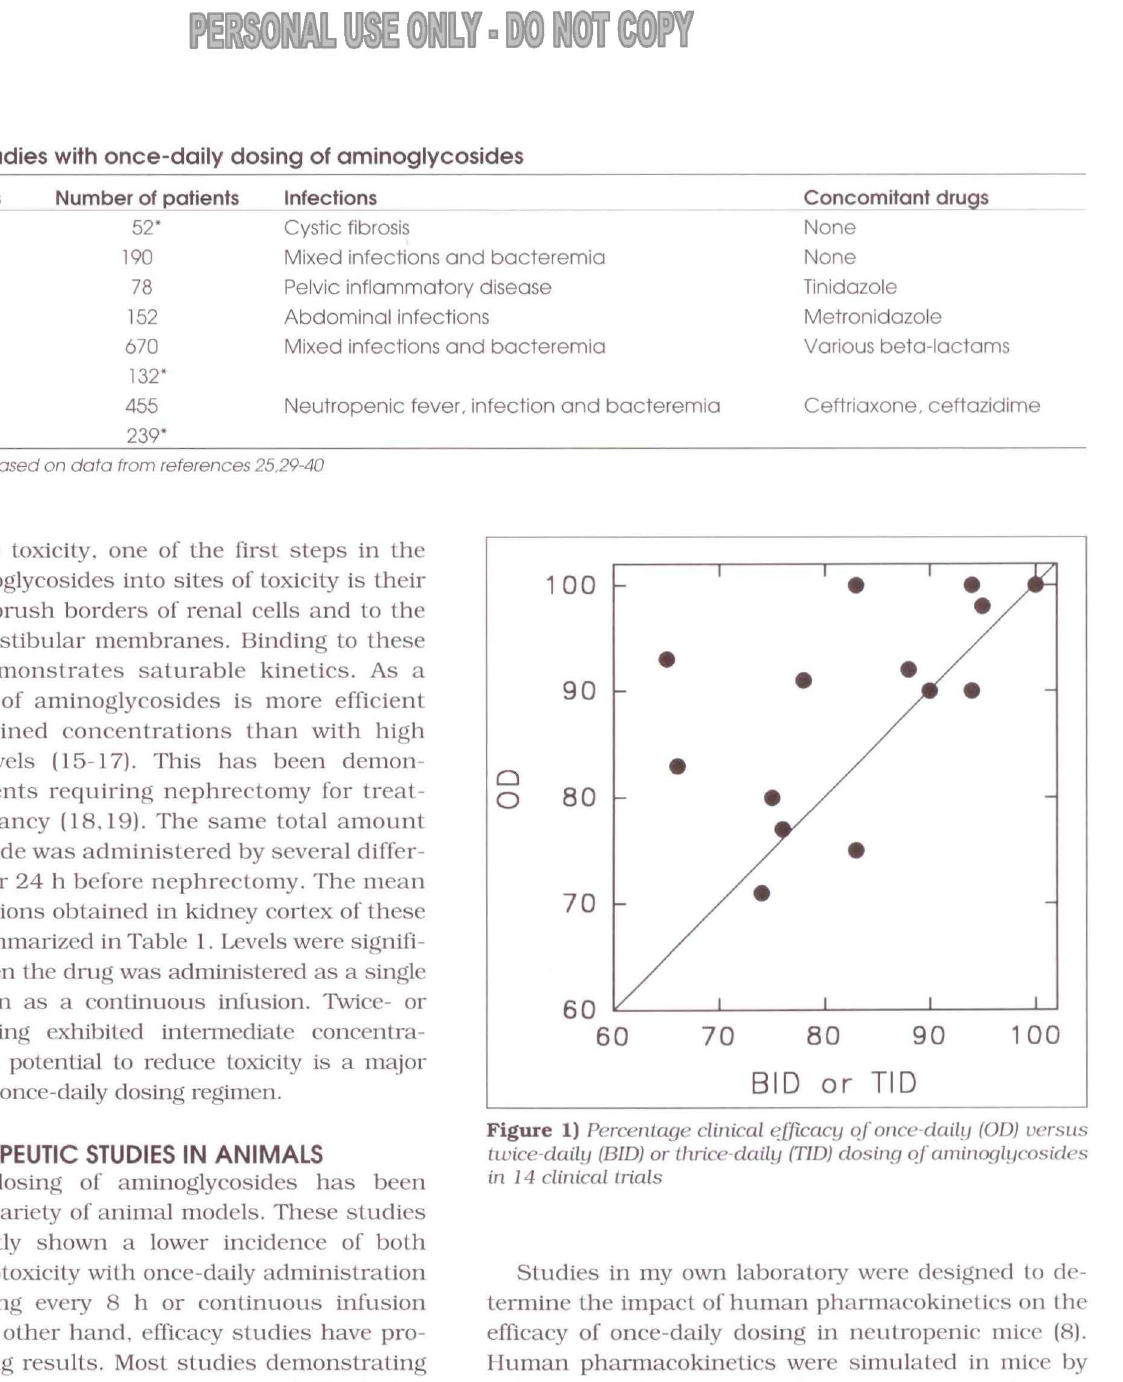
Figure 1) Percenlage clinical eJficacy of once-daily (OD) uersus lwice-daily (BID) or lhrice-daily (TID) dosing of